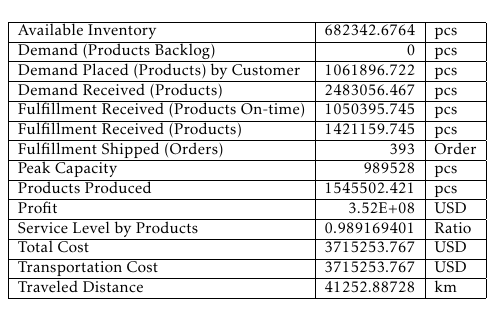
Figure 13. Inventory Policies and Demand